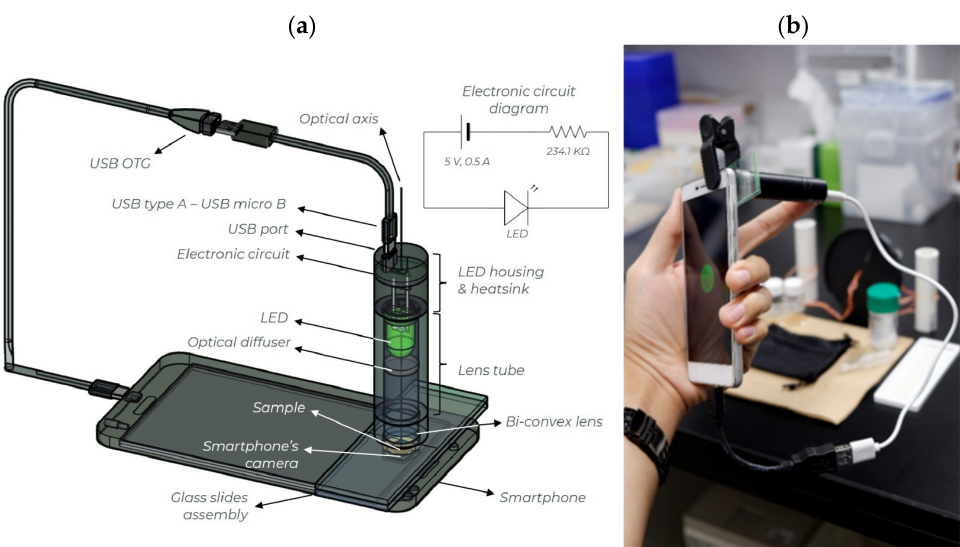
Figure 2. ( a ) Details of the optical attachment; ( b ) the attachment with the